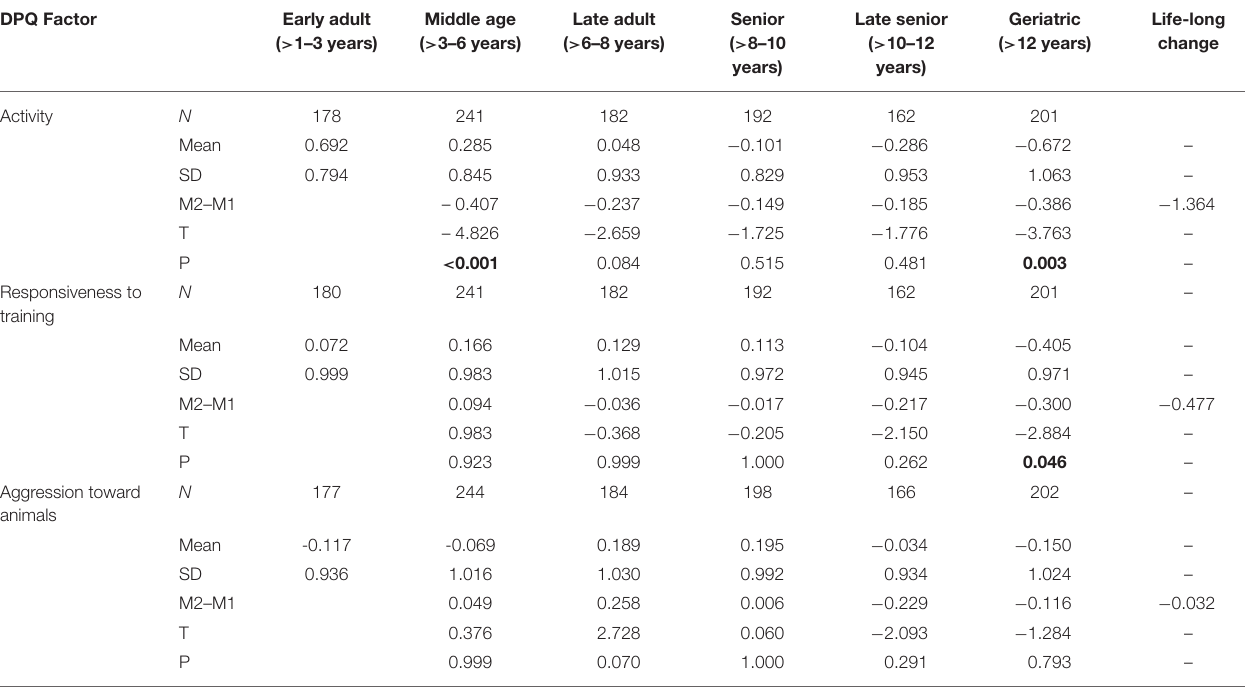
TABLE 3 | Results of the linear models of the three PCA factors of the DPQ where a significant relationship with age group was